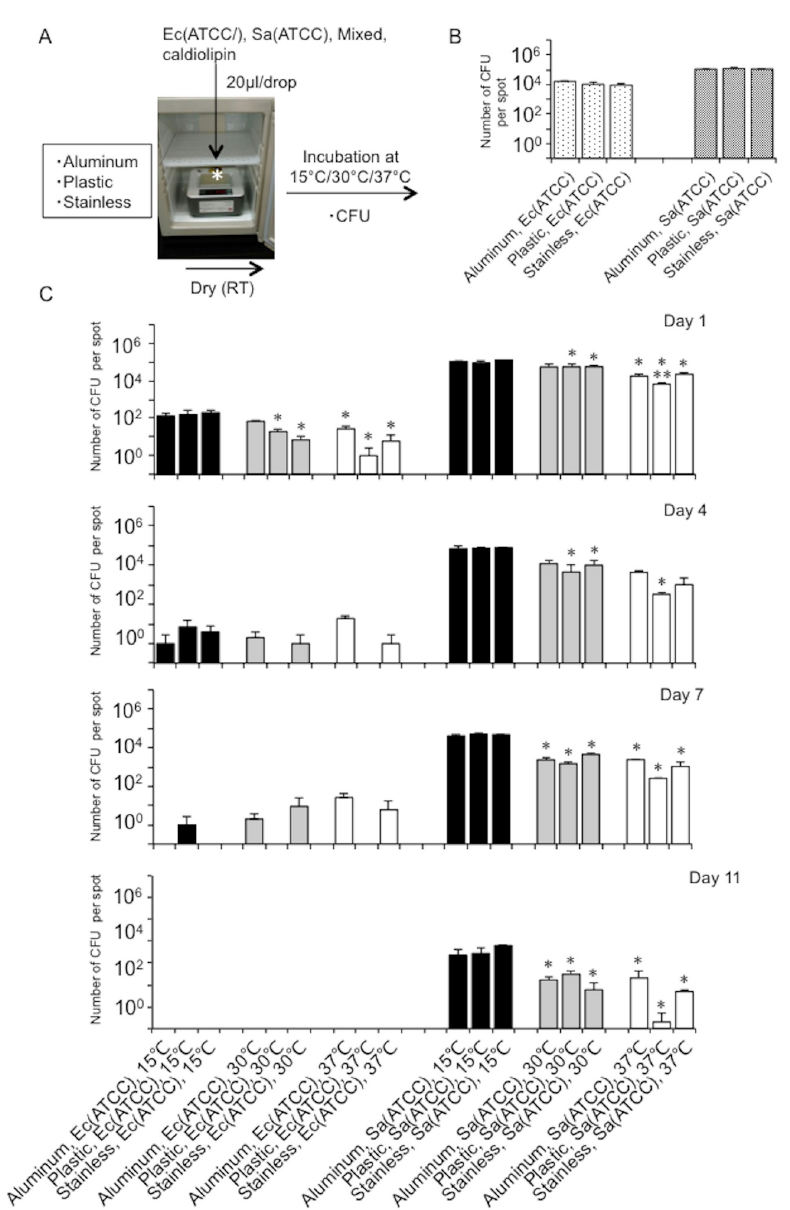
Fig 3. Representative human pathogenic bacteria favor lower temperatures for their survival on other surfaces (aluminum, plastic, stainless steel). A . Experimental protocol. Bacterial survival was monitored for mixed or single bacteria on other surfaces (aluminum, plastic, stainless steel) at distinct temperature (15˚C, 30˚C, 37˚C) for 11 days by a CFU assay (CFU). Ec, E . coli (ATCC 25922). Sa, S . aureus (ATCC 29213). B . Bacterial numbers immediately (within 20 min) after drying. Ec, E . coli (ATCC 25922). Sa, S . aureus (ATCC 29213). C . Changes in bacterial numbers at distinct temperatures (15˚C, 30˚C, 37˚C) over 11 days, as determined by a CFU assay. Ec, E . coli (ATCC 25922). Sa, S . aureus (ATCC 29213). � , p < 0.05 vs. the values at room temperature. �� , p < 0.05 vs. 30˚C. (ATCC 25922), S . aureus (ATCC 29213), or a mixture] on a range of common materials (vinyl chloride, aluminum, plastic, stainless steel) at distinct temperatures (15˚C, 30˚C, 37˚C) for 11 days, by assessing the CFU numbers (Fig 3A). Immediately (approximately 1 h) after drying, no differences in bacterial numbers were detected between the different materials (Fig 3B).